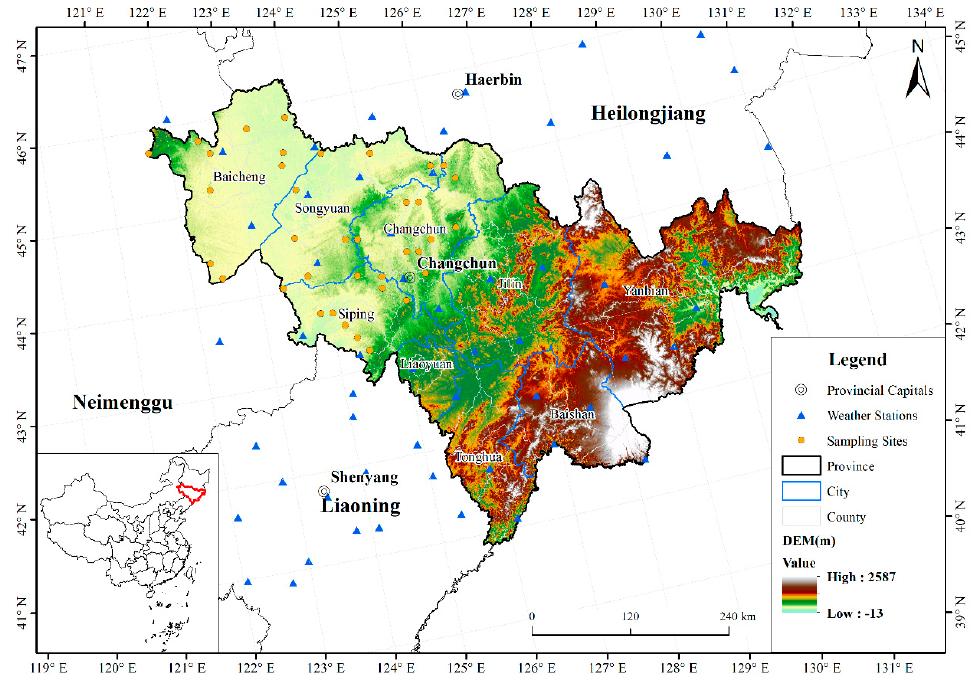
Figure 7. Location of the study area, sampling sites for extraction of planting area, and DEM map.